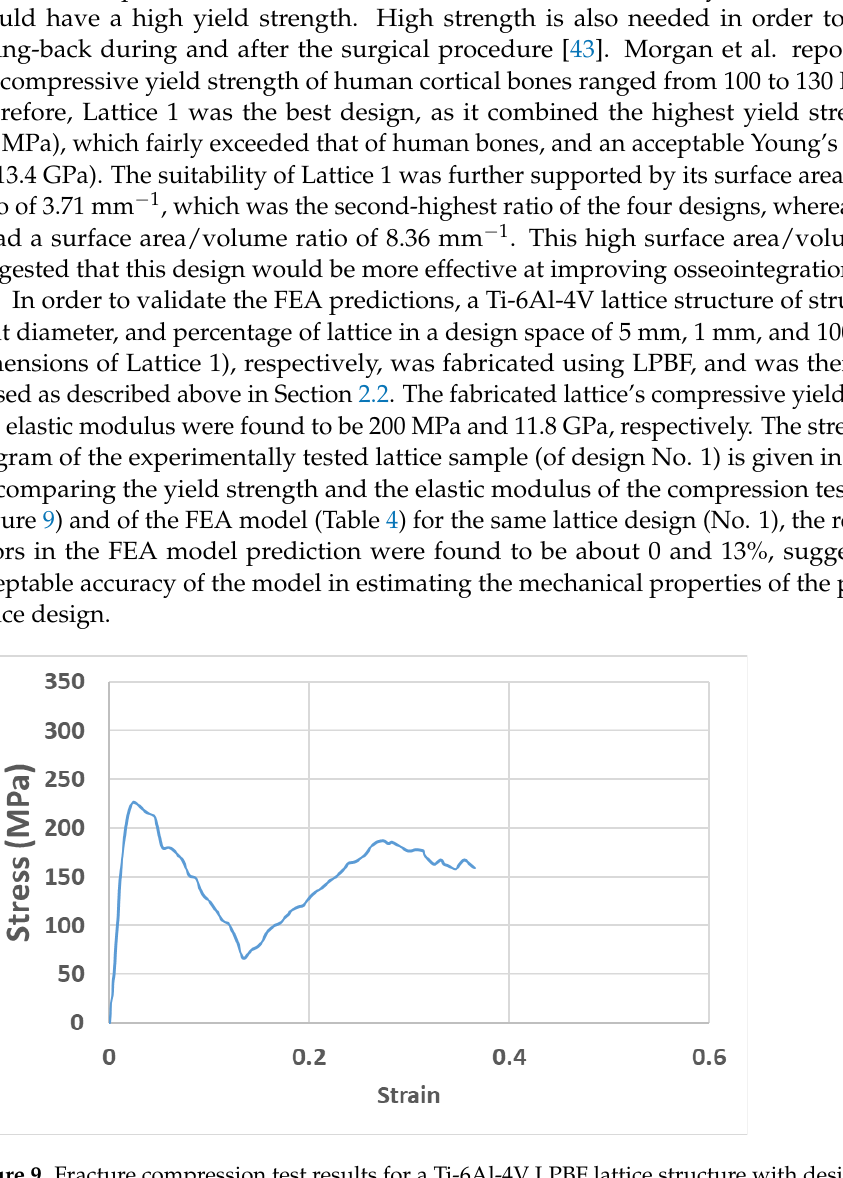
Figure 9. Fracture compression test results for a Ti-6Al-4V LPBF lattice structure with design dimen- sions of Lattice